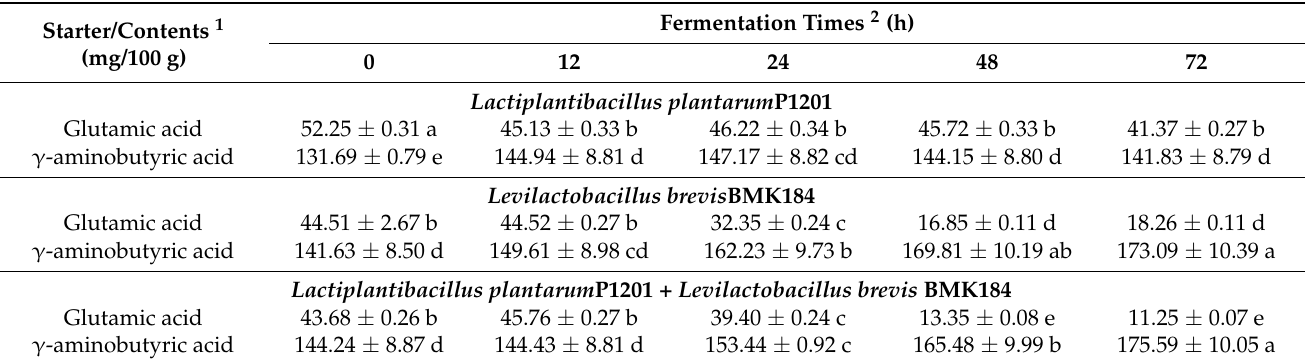
Table 2. Changes of glutamic acid (GA) and γ -aminobutyric acid (GABA) contents during